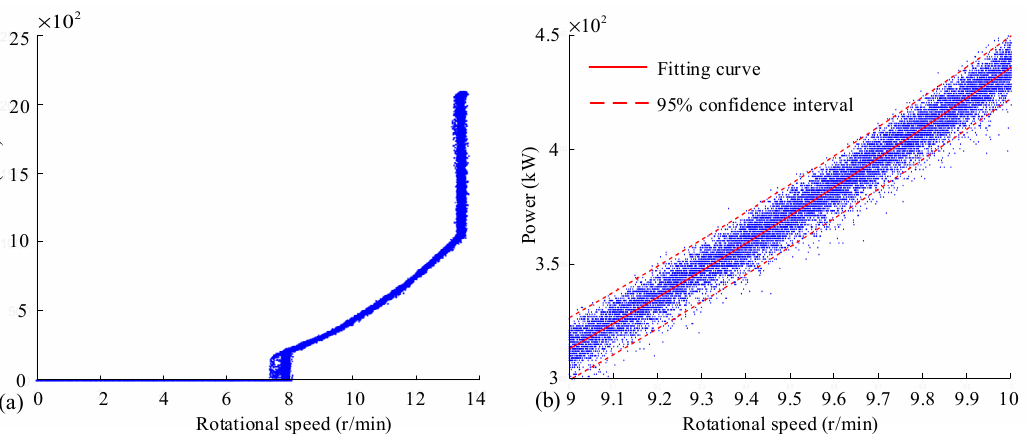
Figure 14. Rotational speed–power curve directly constructed from SCADA data. ( a ) rotational speed–power curve in full range; ( b ) rotational speed–power curve in the maximum wind energy tracking stage.